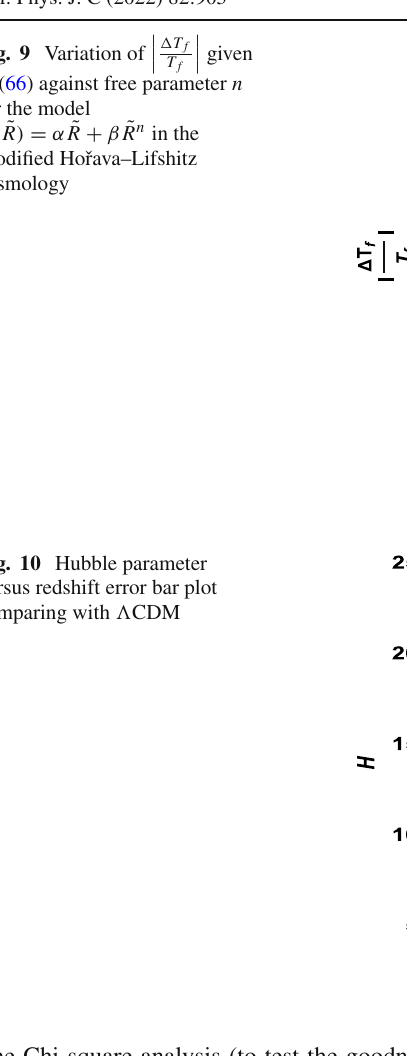
Fig. 9 Variation of in (66) against free parameter n for the model F ( ˜ R ) = α ˜ R + β ˜ R n in the Modified Hoˇrava–Lifshitz cosmology